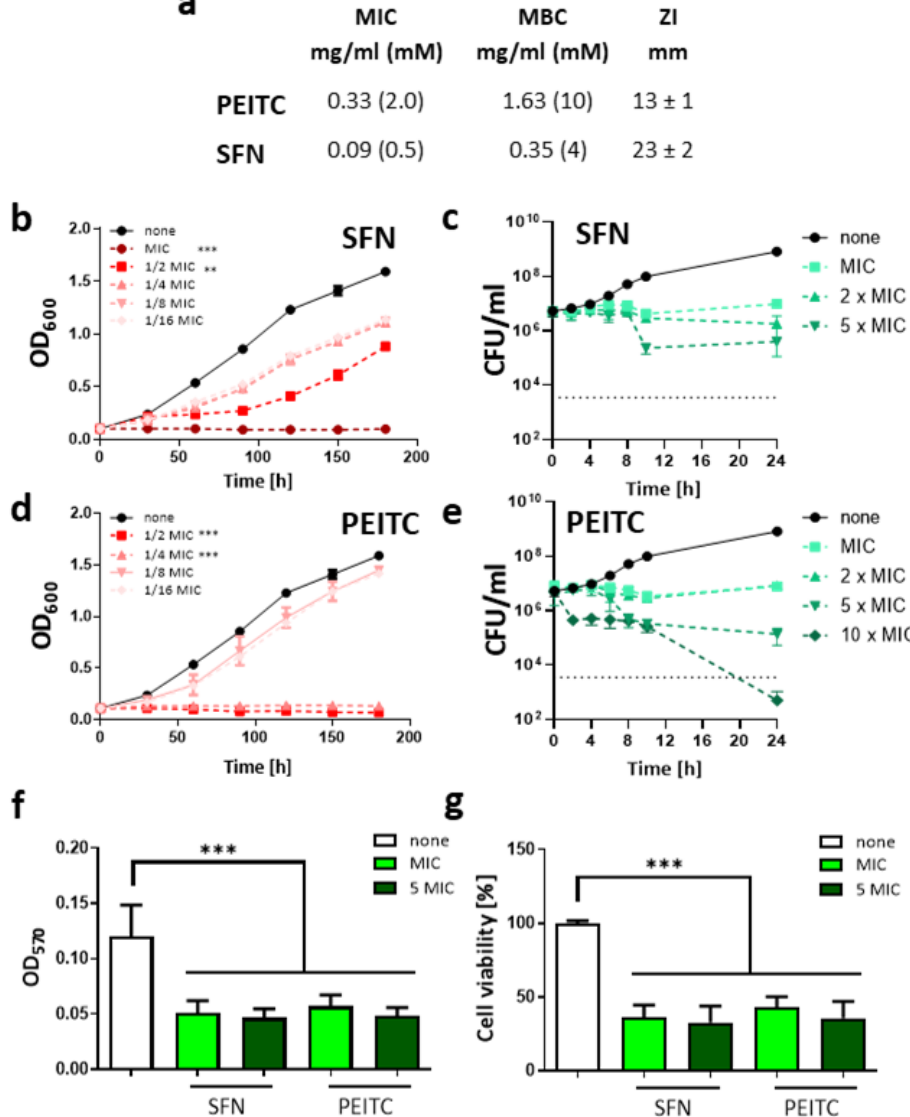
Figure 1. Antimicrobial activity of PEITC and SFN against V. cholerae. The V. cholerae susceptibility tests evaluated as min- imal inhibitory (MIC) and bactericidal (MBC) concentration and zone inhibition assays. ( a ) The growth inhibition of V. cholerae treated with various concentrations of SFN ( b ) and PEITC ( d ). The killing curves of bacteria treated with SFN ( c ) and PEITC ( e ) in doses equal or greater than MIC. The results presented are mean values from 3 independent experiments with SD indicated. The reduction/inactivation of formed biofilm was assessed by crystal violet staining ( f ) and MTT assay ( g ). The significance of differences between treated samples and the controls was tested using the Student ’ s t -test. Statis- tical significance is marked with asterisks: *** p < 0.001; ** p < 0.01.